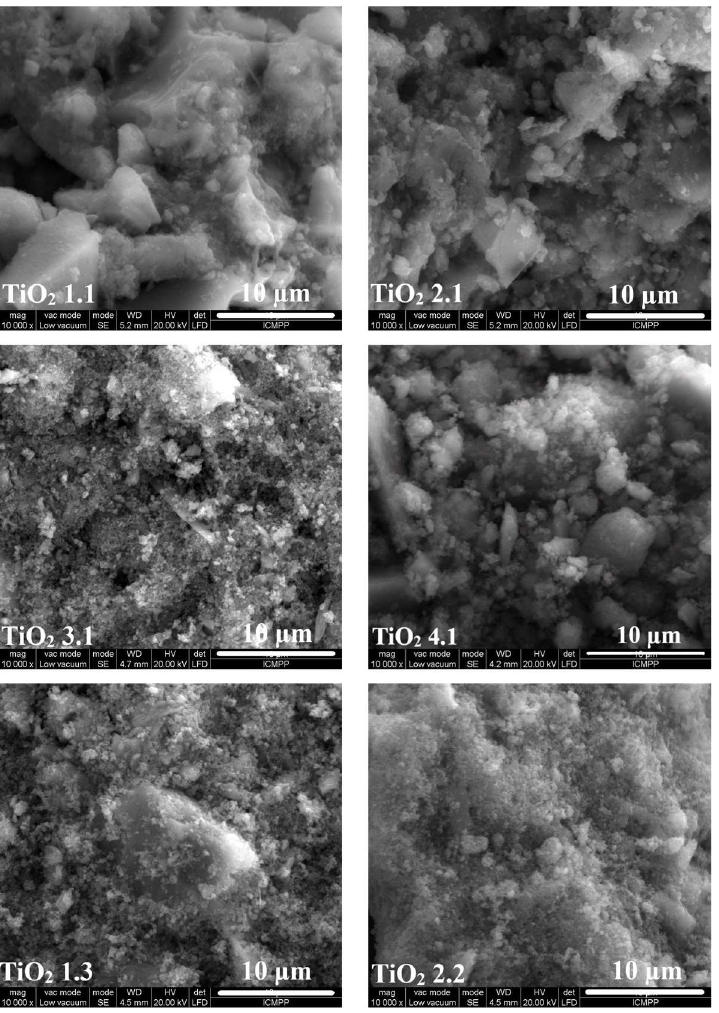
Figure 5. SEM images for the synthesized TiO 2 samples by considering different ultrasonication regimes (magnification 10,000×, bar 10 µm).